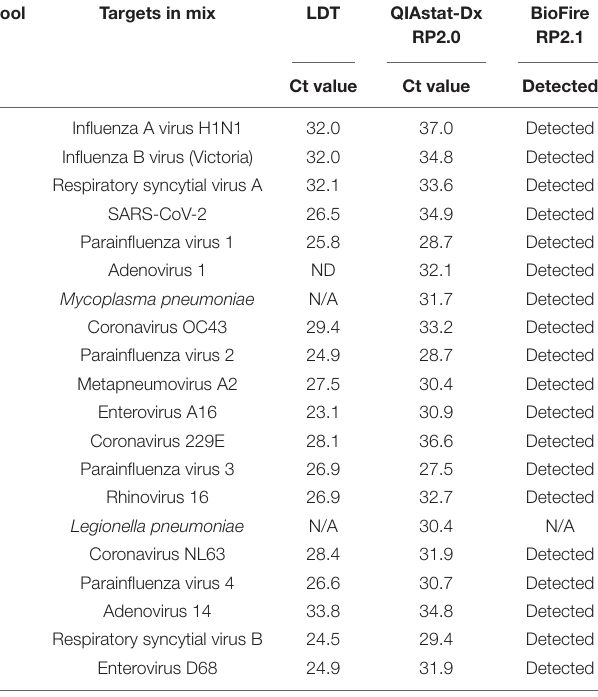
LDT, laboratory developed test (respiratory screen); Ct, cycle threshold; ND, not detected; N/A, not applicable. TABLE 4 | Performance of the QIAstat-Dx RP2.0 on single